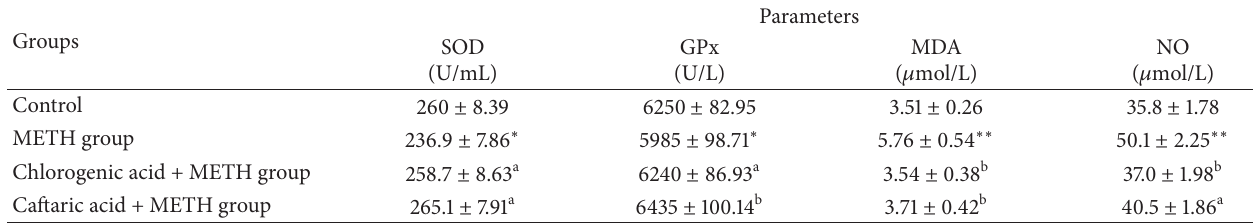
Table 4: Effect of chlorogenic and caftaric acids on blood SOD and GPx, serum MDA, and plasma NO of METH-injected rats. Groups Control